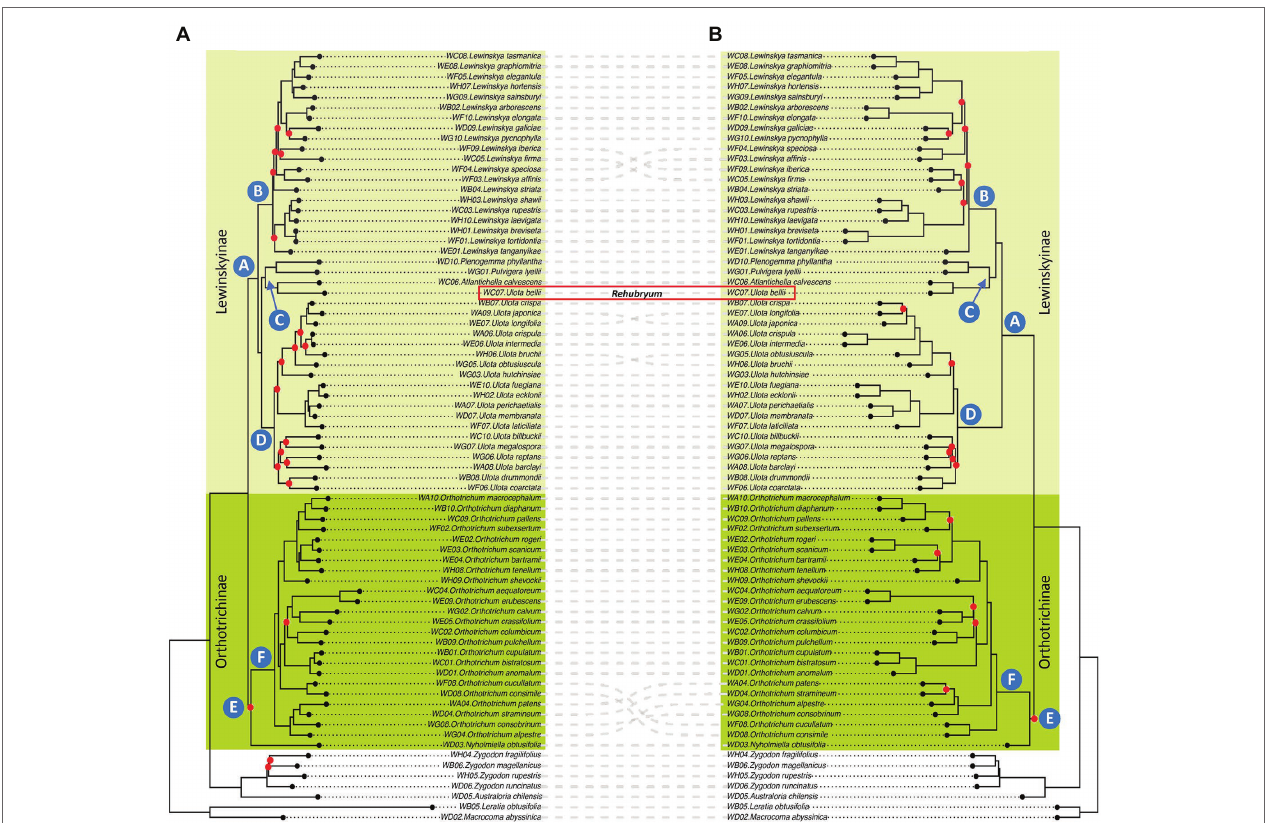
FIGURE 1 | Phylogenetic reconstructions: (A) IQ-TREE analysis of the Probe Only supermatrix: concatenation of 21,501 bp after Gblocks pruning. Red dots indicate nodes with ultrafast BS lower than 90. (B) ASTRAL analysis of the Probe Only supermatrix: consensus phylogeny based on a total of 405 trees after tBLASTx, with branches with less than 50 BS collapsed. Red dots indicate nodes with LPP lower than